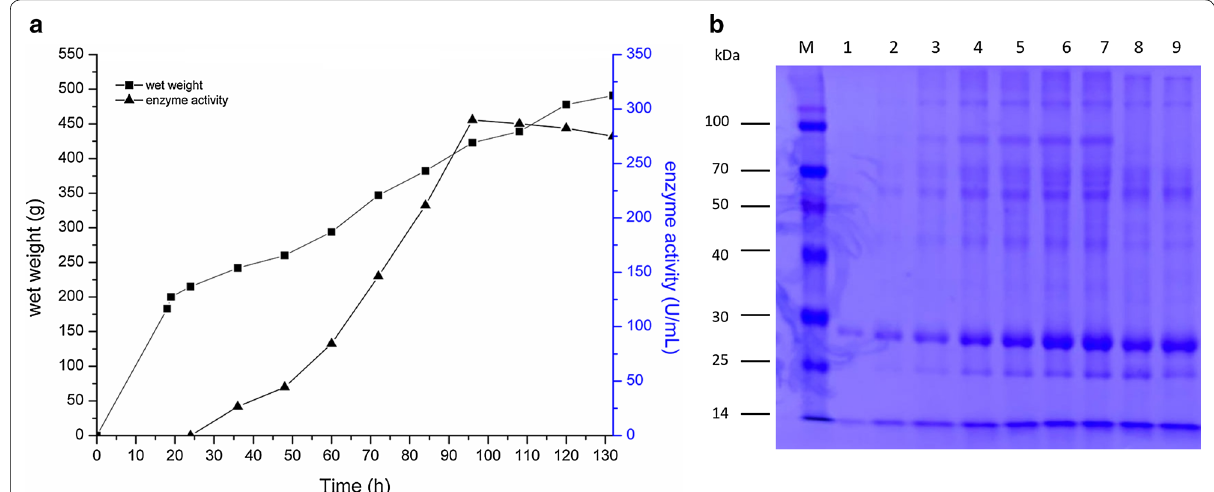
Fig. 3 High-density fermentation of recombinant P. pastoris expressing ZENC in a 30-l fermenter. a Wet weight of cells and enzyme activity. b SDS-PAGE analysis of culture supernatant from the 30-l fermenter at different periods of incubation time; Lanes 1–9, sample supernatants from culture induced with methanol for 12, 24, 36, 48, 60, 72, 84, 96 and 108 h,